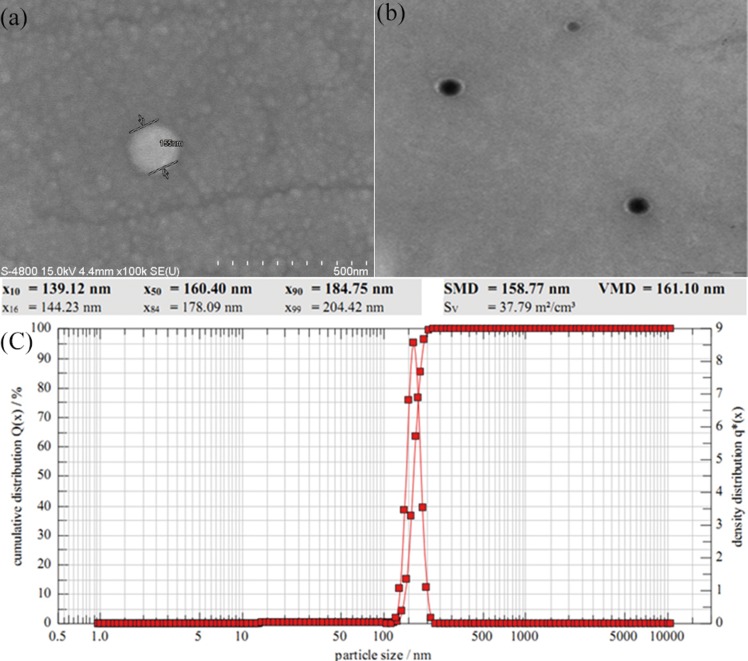
Albumin-bound As2O3 microscopy images and Laser Diffraction Size Analyzer.(a), (b) Show albumin-bound As2O3 microscopy images by scanning electron microscope and transmission electron microscope respectively. (c) Laser Diffraction Size Analyzer showed the particle size of albumin-bound As2O3.